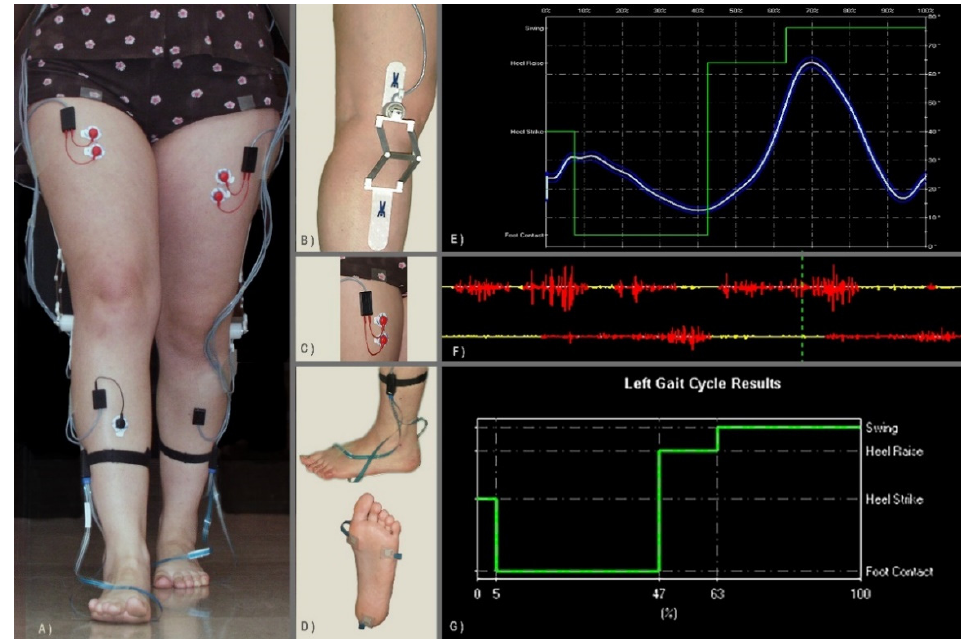
Figure 4. Sensor placement and recorded signals. SEMG active probes are positioned over the main muscles of the lower limb, bilaterally. Electrogoniometers are attached to the lateral aspect of the knee joints. Foot-switches are placed beneath the heel, the first, and the fifth metatarsal heads of each foot. ( A ) Subject performing an evaluation session. ( B ) Detail of the electrogoniometer attached to the lateral aspect of the knee to measure the knee joint angles during gait. ( C ) Detail of a variable geometry sEMG probe attached over the Rectus Femoris muscle of the subject. ( D ) Detail of the foot-switches attached underneath the first and fifth metatarsal heads and the heel (lower picture); how the foot-switches are attached to their connector (upper figure). ( E ) Example of the average variation of the knee joint angle over a given number of strides superimposed to the correspondent four-level coded foot-switch signal. ( F ) Example of two sEMG signals (Tibialis Anterior, upper trace; Gastrocnemius Lateralis, lower trace) collected during gait and processed by the user-independent activation detector: the yellow color means that the muscle is not electrically active and red color means that the muscle is electrically active. ( G ) Example of a four-level coded foot-switch signal: the four levels correspond to Heel strike (H phase), Flat foot contact (F phase), heel raise or Push off (P phase), and Swing (S phase); the sequence of foot-contact phases here represented corresponds to that observed in normal subjects during level